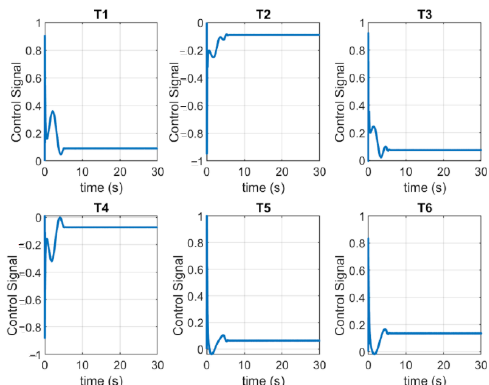
Figure 7. Control signal for each thruster. Simulation with 𝑡 𝑏 = 5 s .